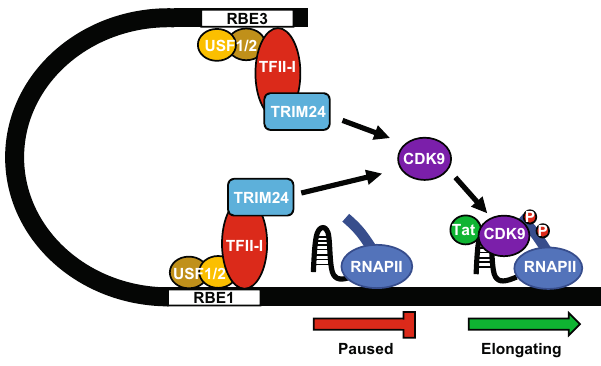
Fig. 10 TRIM24 is an RBF-2 cofactor that stimulates transcriptional elongation of HIV-1. The TFII-I component of RBF-2 directly interacts with, and recruits TRIM24 to the HIV-1 LTR. TRIM24 is essential for T-cell signal- induced activation of the chromosomally integrated provirus and is required for recruitment of P-TEFb/CDK9 to the LTR, and phosphorylation of Ser-2 of the RNA Pol II CTD, to promote